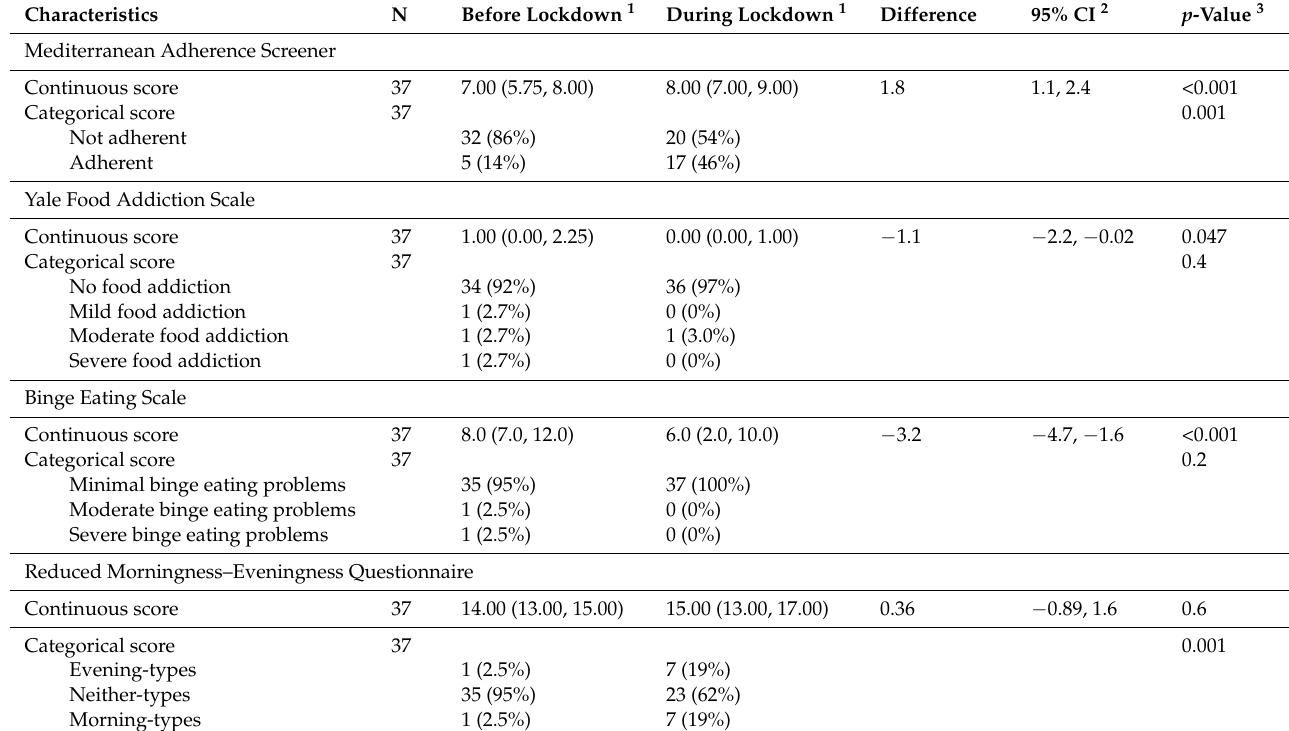
Table 4. Differences of questionnaires scores before and during